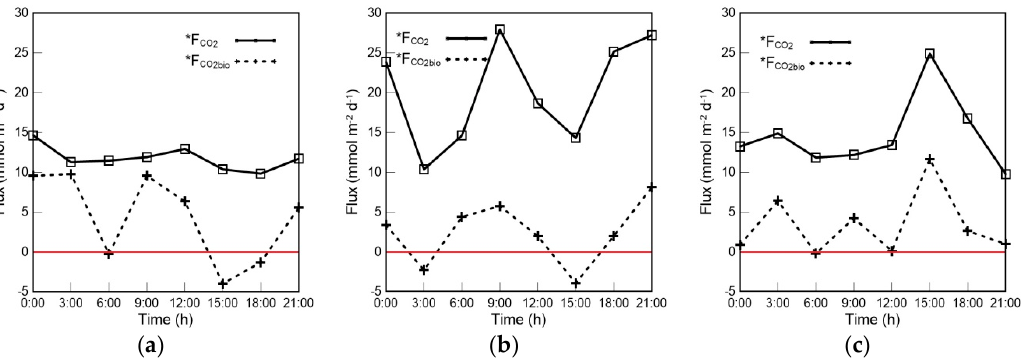
Figure 7. Twenty-four-hour variations in potential carbon flux (*F CO2 ) and the biological contribution to carbon flux (*F CO2bio ) in the near-shore ( a ), front ( b ), and offshore ( c ) regions in